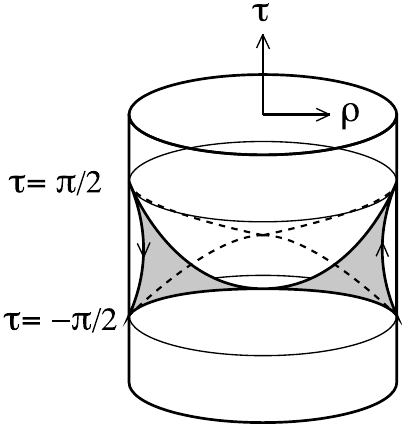
π/ 2 at the boundary of AdS. ±